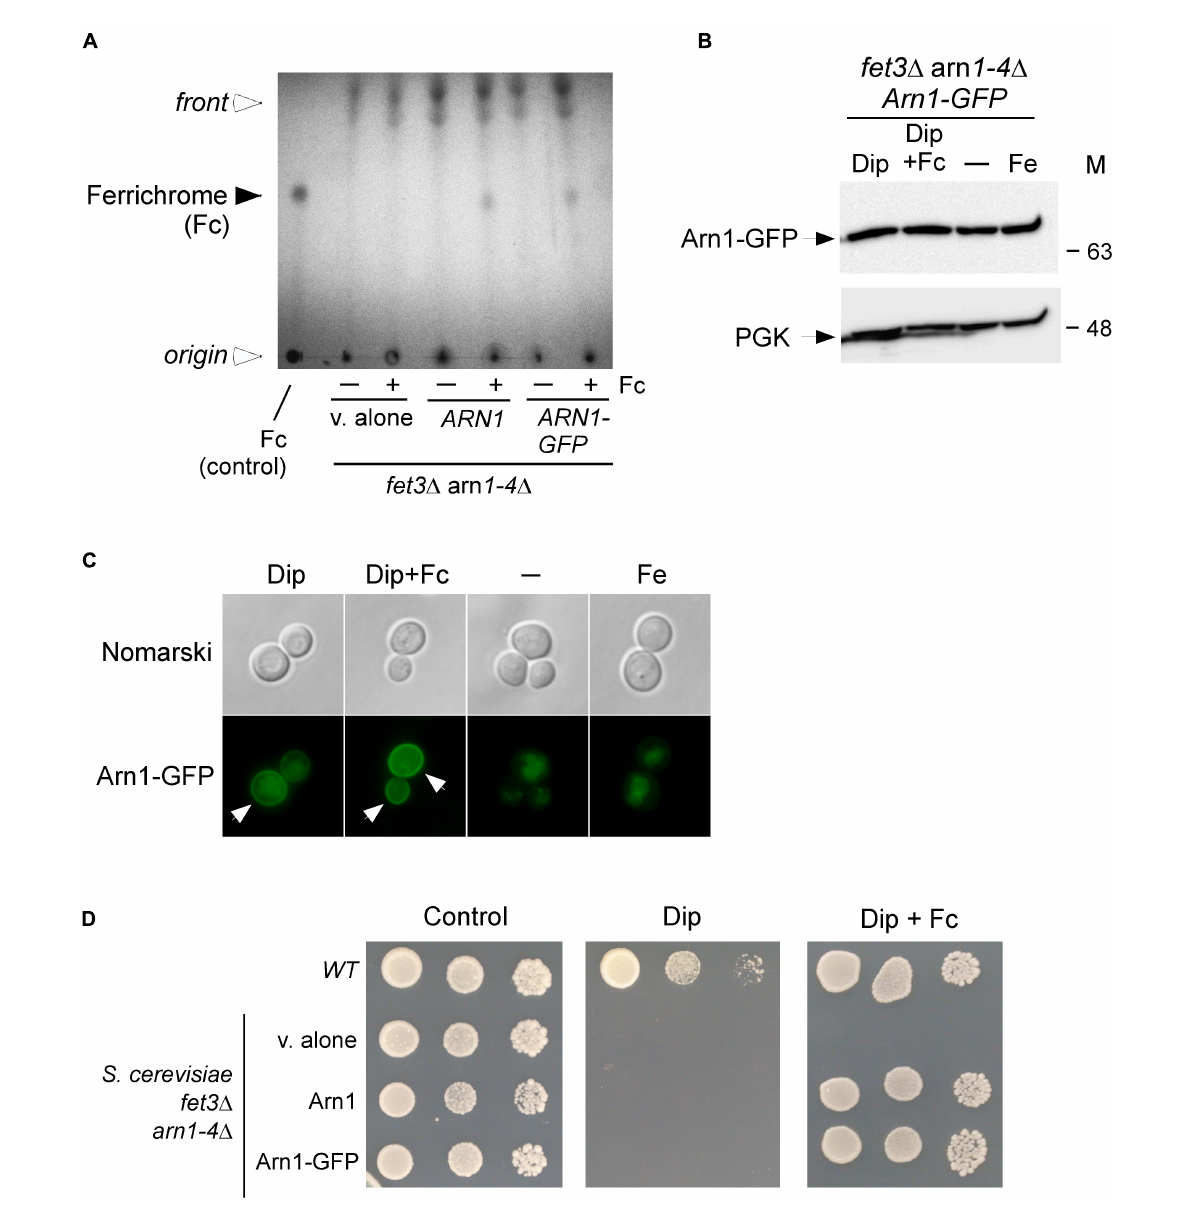
FIGURE1 Expression of ARN1 in S. cerevisiae fet3 (cid:49) arn1-4 (cid:49) cells complements the Fc acquisition deficiency of cells defective in the uptake of Fc. (A) S. cerevisiae fet3 (cid:49) arn1-4 (cid:49) mutant cells expressing an empty plasmid, ARN1 or ARN1-GFP alleles were grown in SC medium to the mid-logarithmic phase. The cells were then incubated in the presence of Dip (100 µ M) without Fc supplementation or with Fc supplementation (2 µ M) for 5 h. Whole extracts were prepared and total Fc content was analyzed by thin-layer chromatography on silica gel sheets. Commercially purified Fc (15 µ g) was run as a reference (control, far left lane). The solid arrowhead indicates the migration position of Fc, whereas the open arrowheads show the position of sample loading and the front of gel migration. (B) S. cerevisiae fet3 (cid:49) arn1-4 (cid:49) cells expressing Arn1-GFP were grown to the mid-logarithmic phase and subsequently left untreated (-) or treated with Dip (100 µ M), Dip plus Fc (2 µ M), or iron (Fe, 100 µ M) for 5 h. Whole cell extract preparations were analyzed using immunoblot assays with anti-GFP and anti-PGK antibodies. The positions of the molecular weight standards (in kDa) are indicated on the right side. (C) Aliquots of cultures used in panel B were analyzed by fluorescence microscopy for visualizing cellular location of Arn1-GFP. Cell morphology was examined using Nomarski optics. White arrows indicate the cell periphery. The results are representative of three independent experiments. (D) Aliquots of cultures used in panel A were spotted in serial dilutions onto medium without Dip or Fc supplementation (control) or supplemented with Dip or a combination of Dip (75 µ M) and Fc (2 µ M). An isogenic wild-type (WT) strain was grown under the same conditions used in (A) and then spotted at different cellular densities onto the same indicated solid media as a control. All plates were incubated for 4 days at 30 ◦ C, and